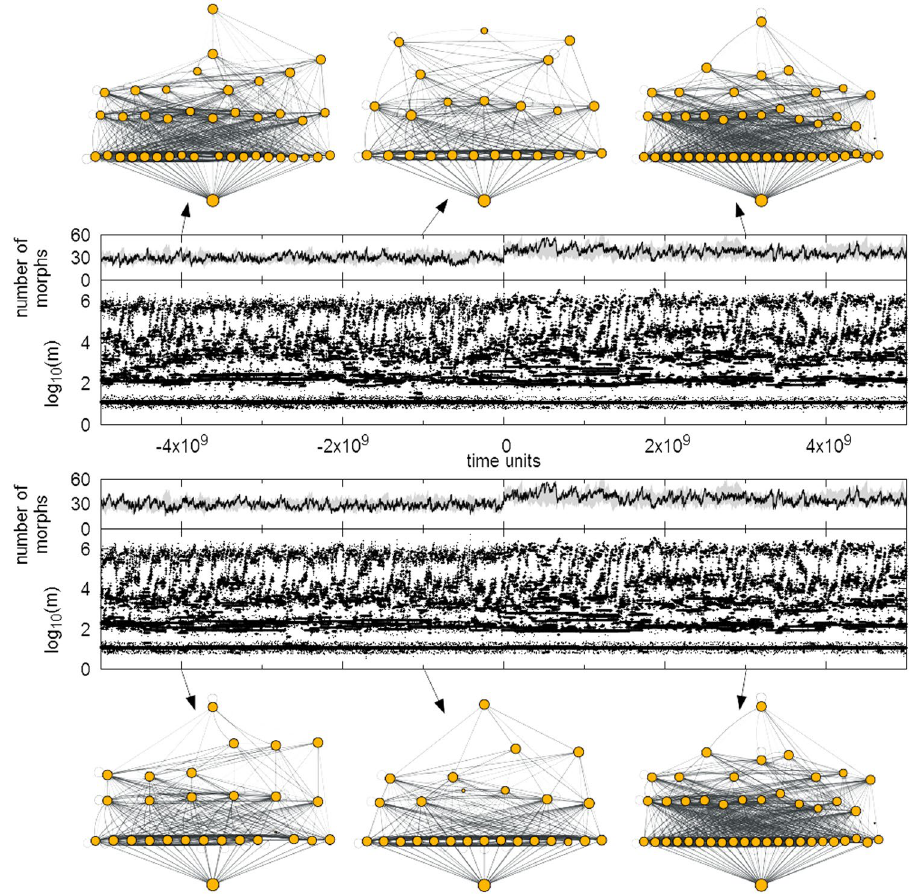
Figure 2. Cutout from a single simulation run for two habitats. Migration is switched on at time t = 0, according to scenario 2 (see methods section for more explanation). Each pair of panels shows respectively the local diversity (measured as the number of morphs present in that habitat) and the body masses of the morphs at a given time for one of two habitats respectively. Grey area shows morph number range for all 10 simulation runs. Network visualizations show examples of food webs at the marked time points. Resource is at the bottom, height shows trophic position and size of the nodes shows population sizes. Note that the food webs become identical after the